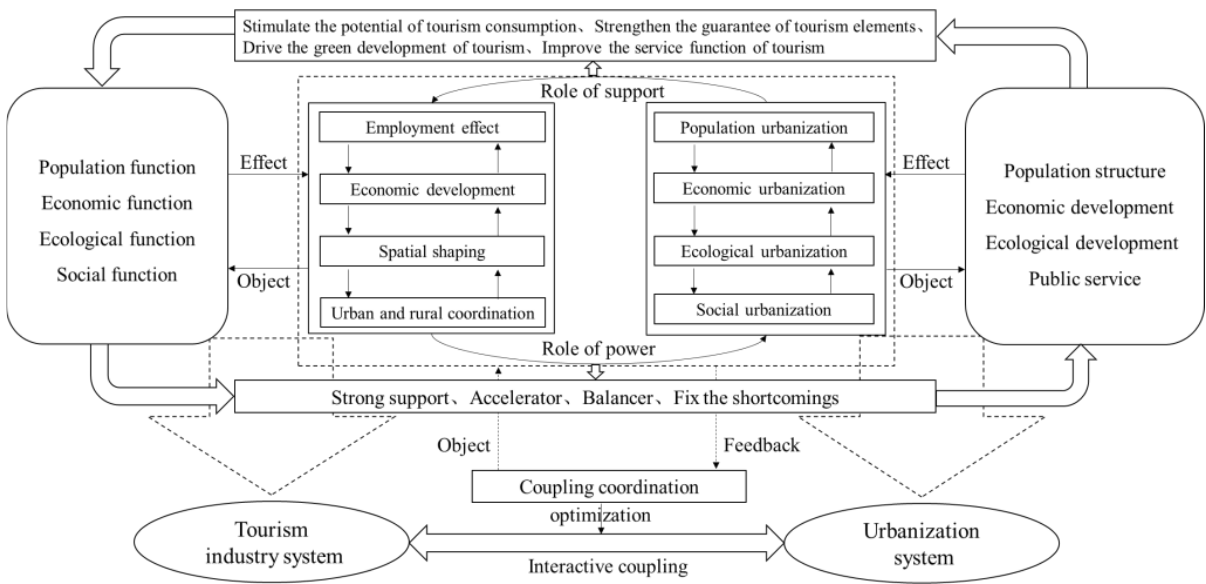
Figure 1. The coupling and coordination mechanism of tourism industry and urbanization.